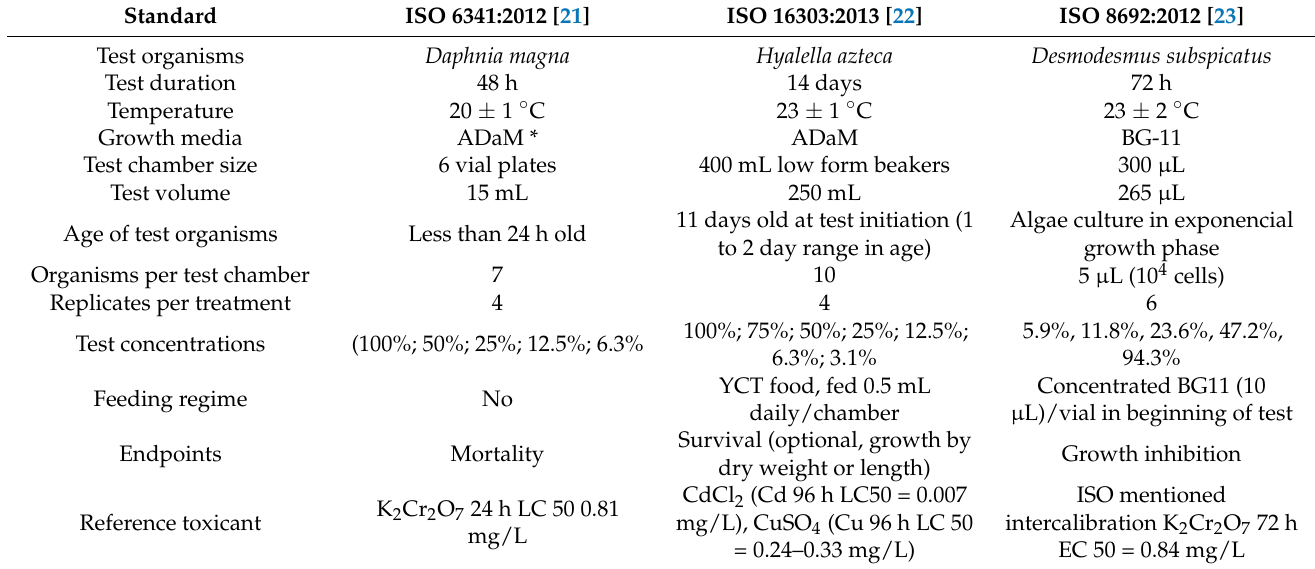
Table 2. Ecotoxicity test conditions